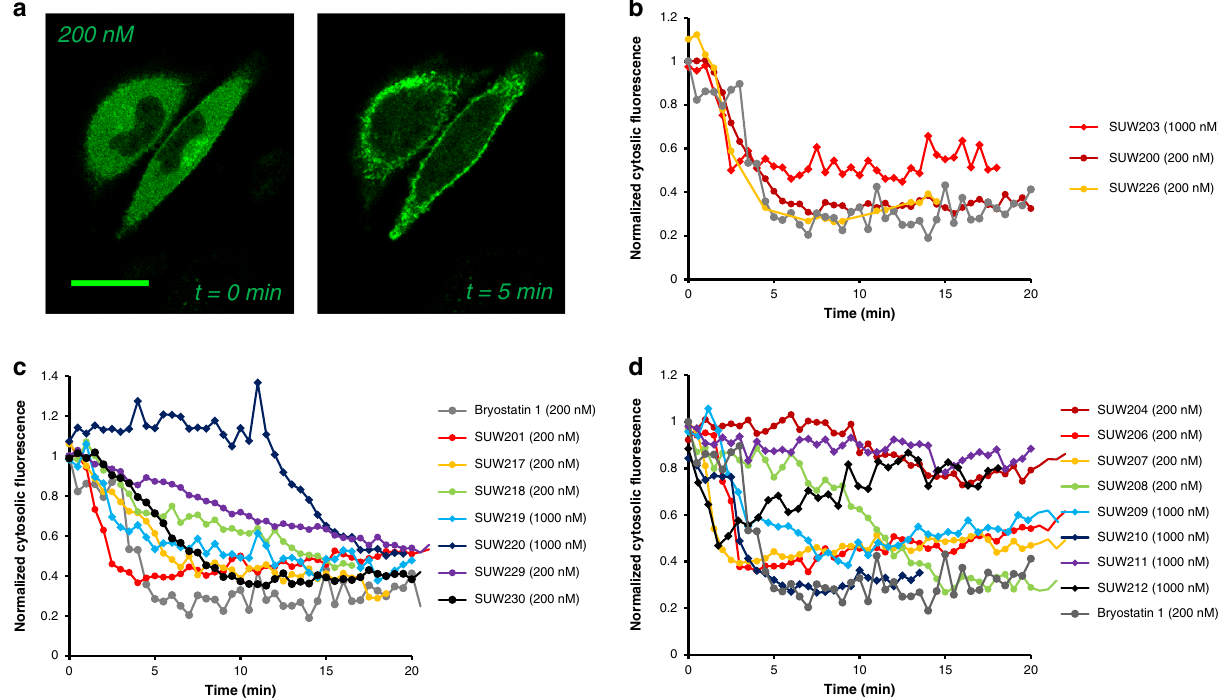
Fig. 5 Bryostatin-induced PKC translocation. a Bryostatin-induced translocation of PKC from the cytosol to the membrane was determined in real time by monitoring cytosolic fl uorescence of a PKC δ -GFP fusion protein using confocal microscopy. Scale bar represents 25 μ m. Experiments performed in n = 3 biological replicates. b – d Cytosolic fl uorescence normalized to t = 0 (time immediately prior to addition of compound to media) and plotted against time. Error bars excluded for clarity (data presented as the mean of n = 3 biological replicates). Individual curves with error bars included in Supplementary Information. Maximum translocation of PKC δ -GFP to the plasma membrane reported in Table